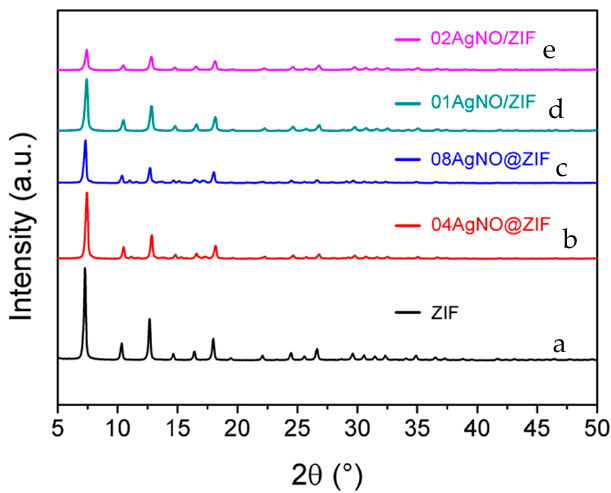
Figure 1. XRD diffraction patterns of ZIF-8 samples with de novo- synthesis (sample as ZIF-8, 04AgNO@ZIF, 08AgNO@ZIF) and impregnation method (sample as 01AgNO/ZIF, 02AgNO/ZIF) using AgNO 3 as the precursor. (a) ZIF-8, (b) 04AgNO@ZIF (de novo), (c) 08AgNO@ZIF (de novo), (d) 01AgNO/ZIF (impregnation), (e) 02AgNO/ZIF (impregnation).